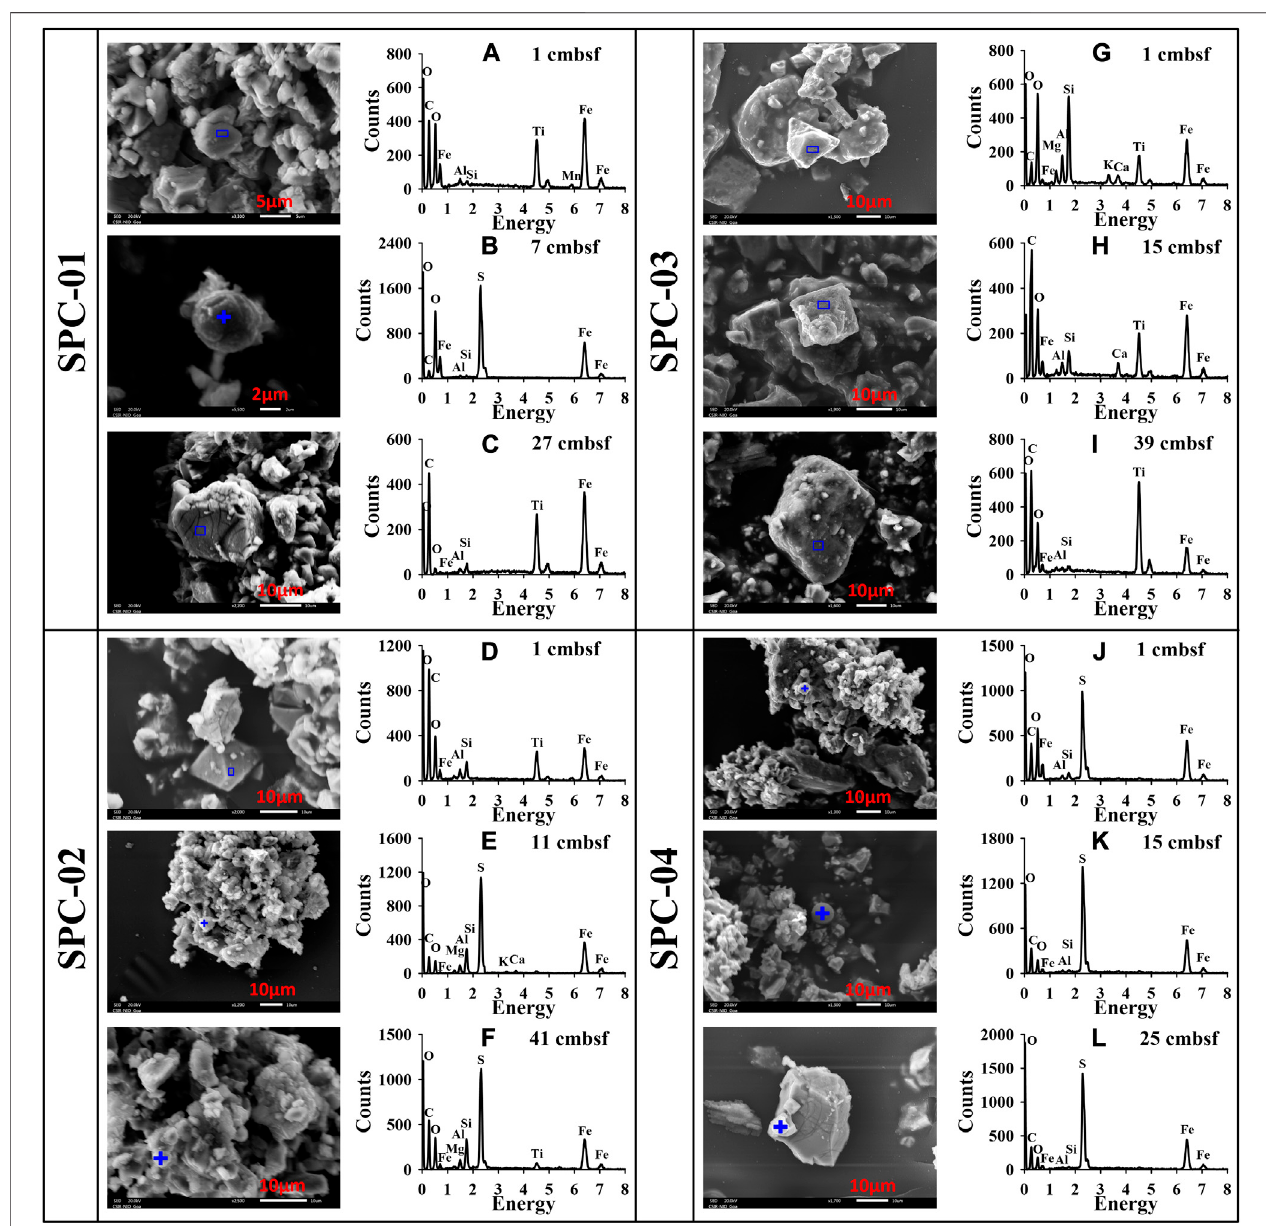
FIGURE 7 | Scanning electron microscopy on magnetic extracts from different sediment core depth intervals. Energy dispersive x-ray spectroscopy spectra are placedadjacent totherespective images. (A – C) :SPC-01, (D – F) : SPC-02, (G – I) :SPC-03, and (J – L) :SPC-04. Iron (Fe),titanium(Ti),sulfur (S),oxygen (O),calcium (Ca), silicon (Si), carbon (C), aluminium (Al), potassium (K), magnesium (Mg), and manganese (Mn) peaks are indicated.